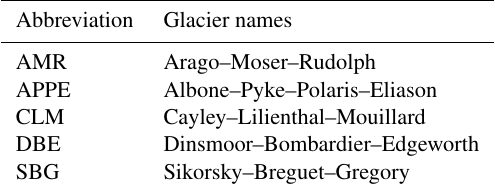
Table 1. Abbreviations of glacier